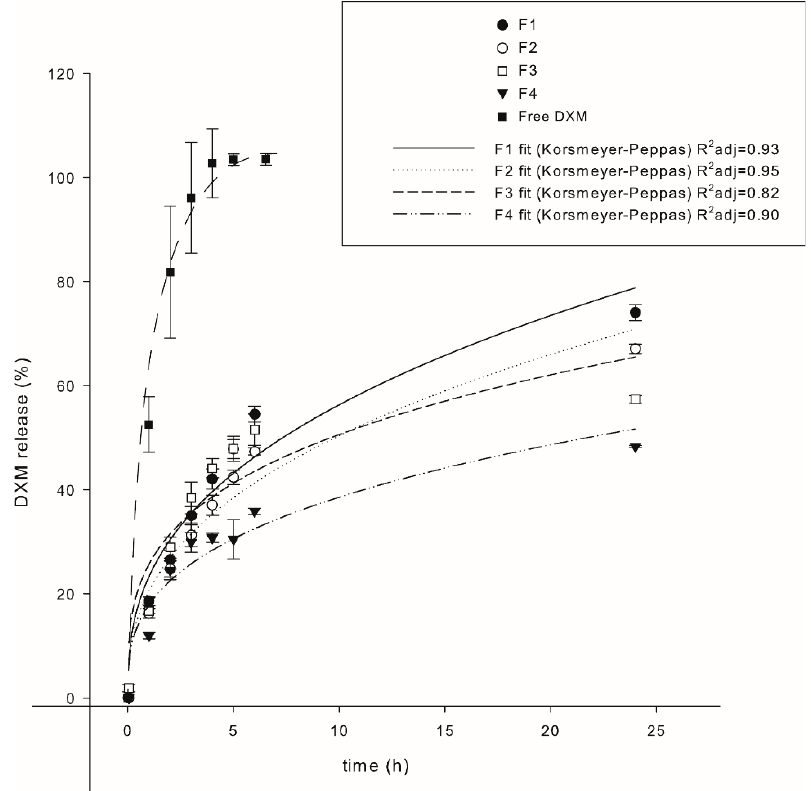
Figure 2. DXM release inversely correlates with oil content of the NLC matrix. Time-dependent DXM release from the different NLC formulations in 10 mM PBS pH 7.4 and 37 °C, ( n = 3).